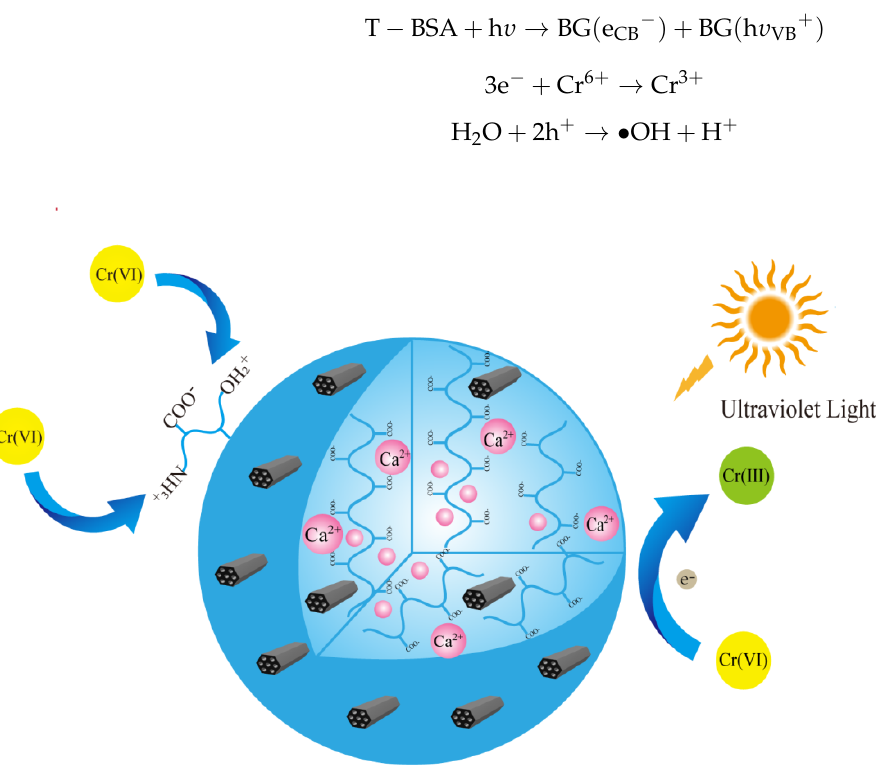
Figure 13. Proposed reaction mechanism of Cr(VI) removal by T-BSA.